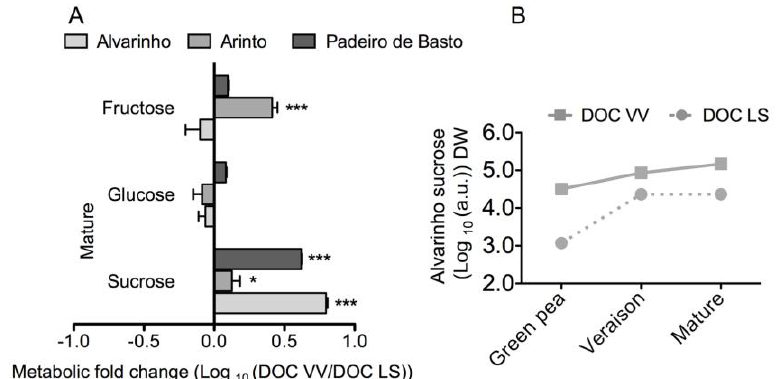
Figure 3. Key sugars in grape berries from Alvarinho, Arinto and Padeiro de Basto cultivated in the DOC VV and DOC LS regions. Levels of sucrose, fructose and glucose at the mature stage are the logarithmic transformed fold change (DOC VV/DOC LS) of berries from Alvarinho, Arinto and Padeiro de Basto ( A ); Logarithmic sucrose levels of Alvarinho during grape berry development and ripening ( B ). Columns represent the means ± SE ( n = 3); asterisks denote the significance levels as comparing DOC VV to DOC LS: * p ≤ 0.05; *** p ≤